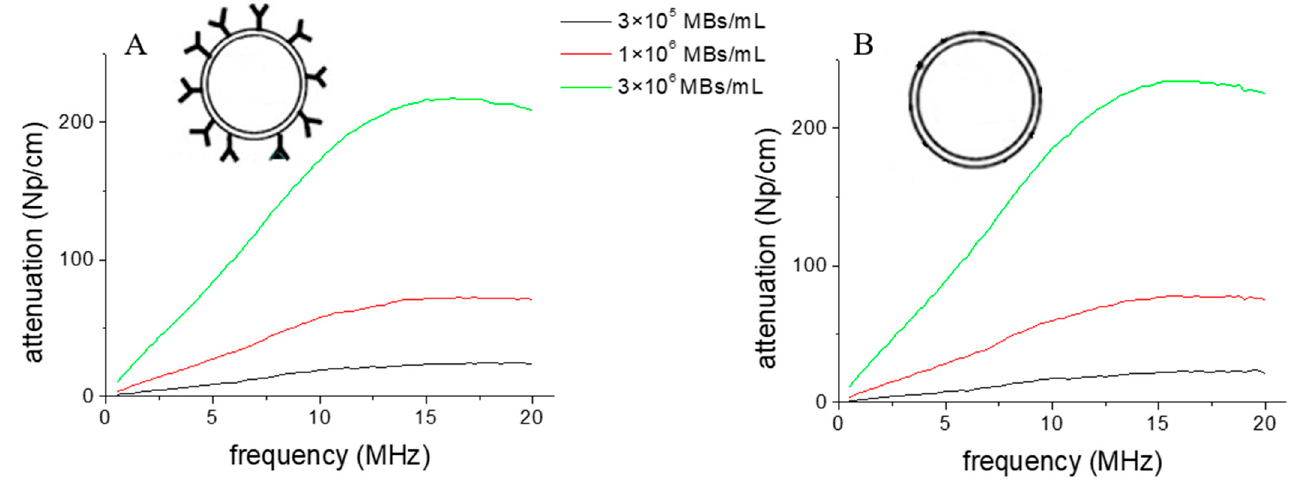
Figure 2. The attenuation coefficient at varying ultrasound frequencies performed on PVA MBs completely covered with cRGD ( A ) and naked PVA MBs ( B ) are compared at three different number densities in water dispersion (3 · 10 6 , 1 · 10 6 , 1 · 10 5 MBs/mL as specified in the graph label). At a fixed number density, the shapes of the corresponding attenuation profiles are identical, with the maximum at the same acoustic resonance frequency of 13.5 MHz.